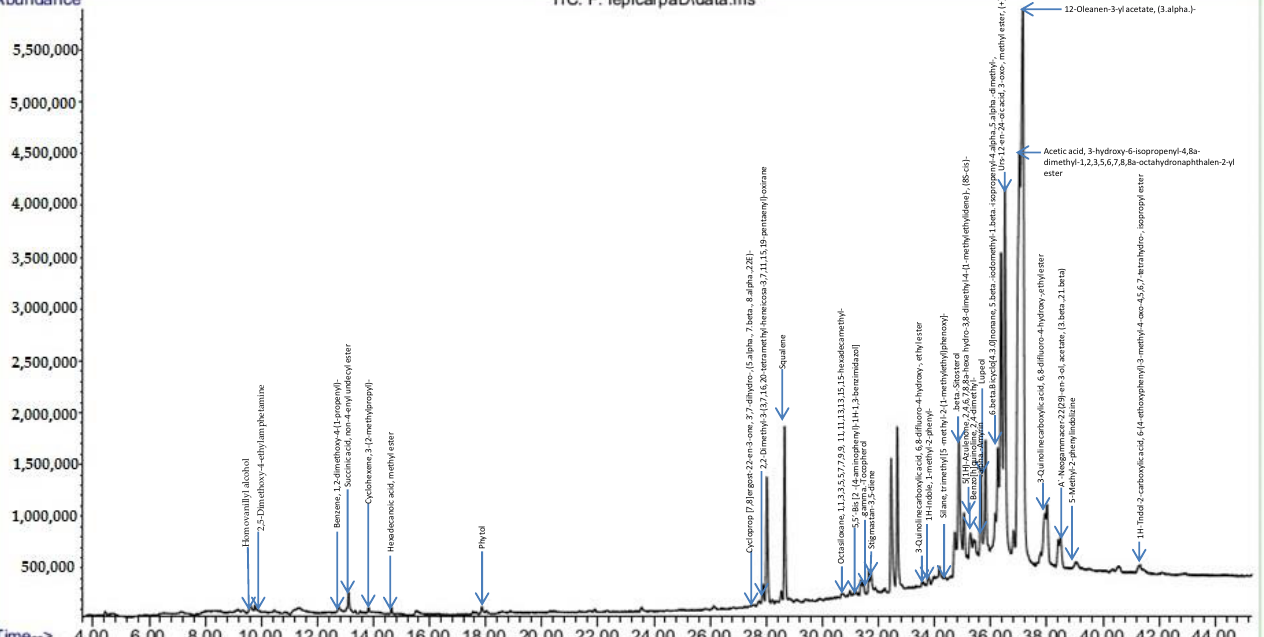
Figure 1. Chromatogram of GC-MS analysis of F. lepicarpa